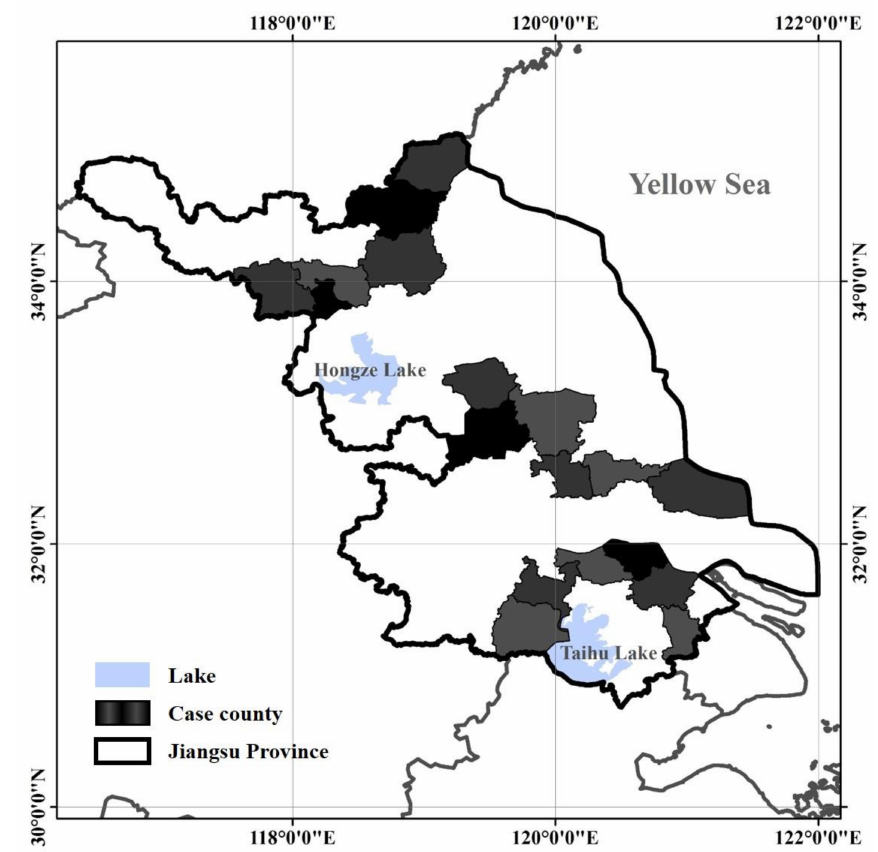
Figure 2. Location of the selected case counties in Jiangsu Province for assessing the performance of the four classification